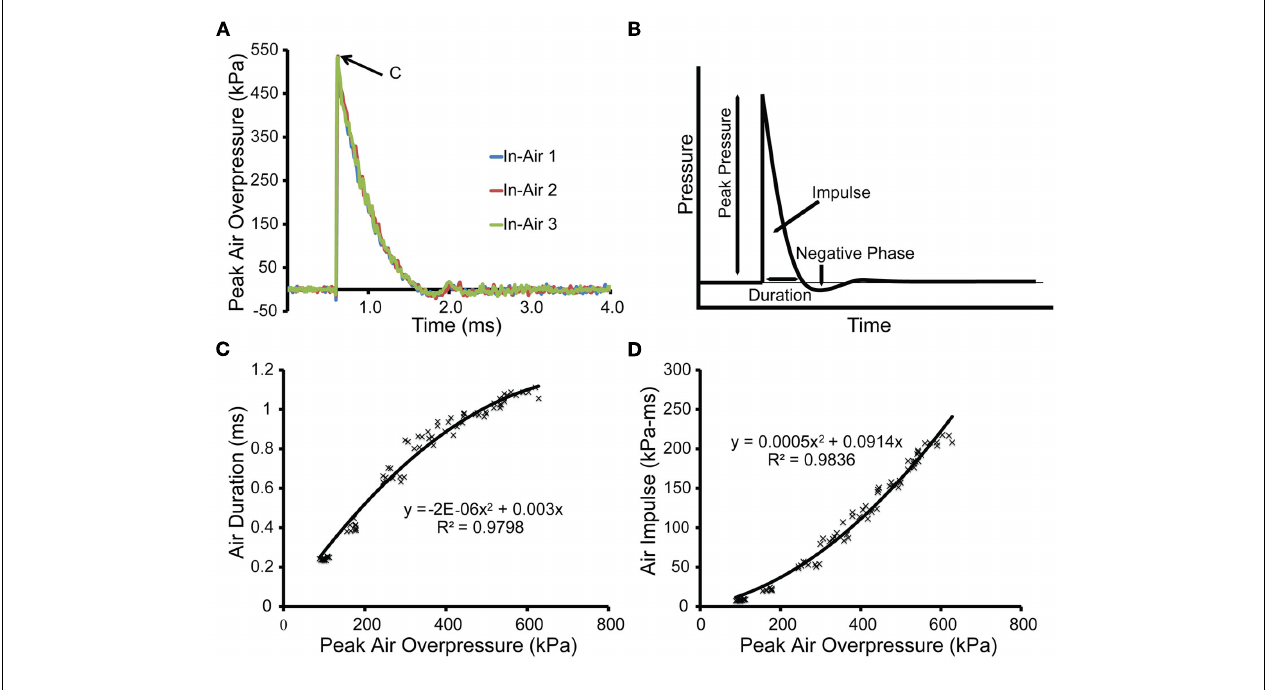
which models the primary blast produced from an explosion in the free-field. (C) For the open shock tube, the durations were plotted as a function of the peak overpressures for each blast and fit to a second-order polynomial ( n = 78). (D) For the open tube, the impulses were plotted as a function of peak overpressures for each blast and fit to a second-order polynomial ( n =